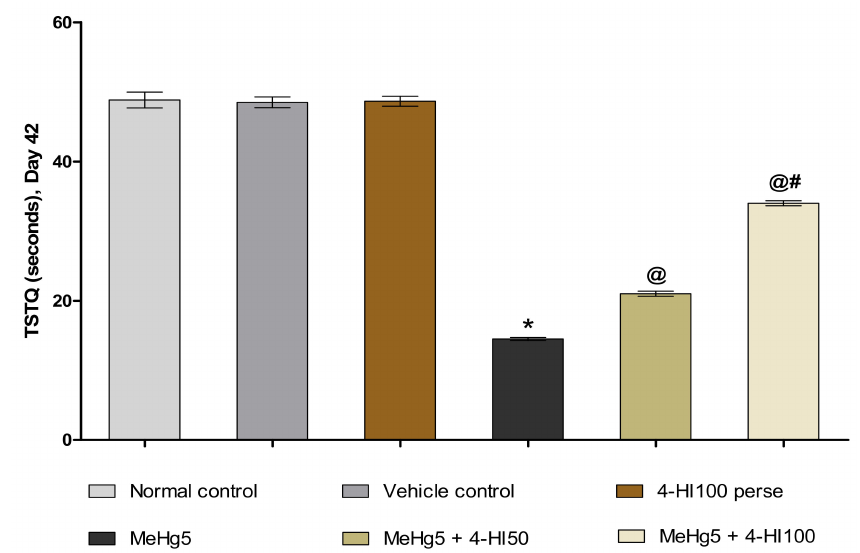
Figure 9. Effect of 4-hydroxyisoleucine on TSTQ after methylmercuryexposure in rats. Statistical analysis by one-way ANOVA (posthoc Tukey’s test). Values are expressed as mean ± SEM ( n = 6 rats per group). * p < 0.001 v/s normal control, vehicle control and 4-HI100 perse ; @ p < 0.001 v/s MeHg5; @# p < 0.001 v/s MeHg5 +